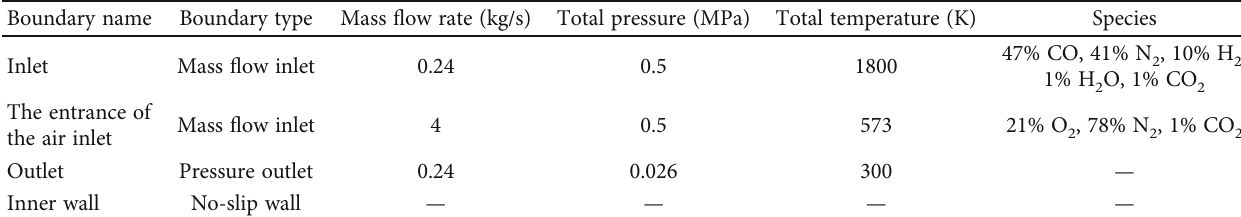
Table 1: Boundary conditions.